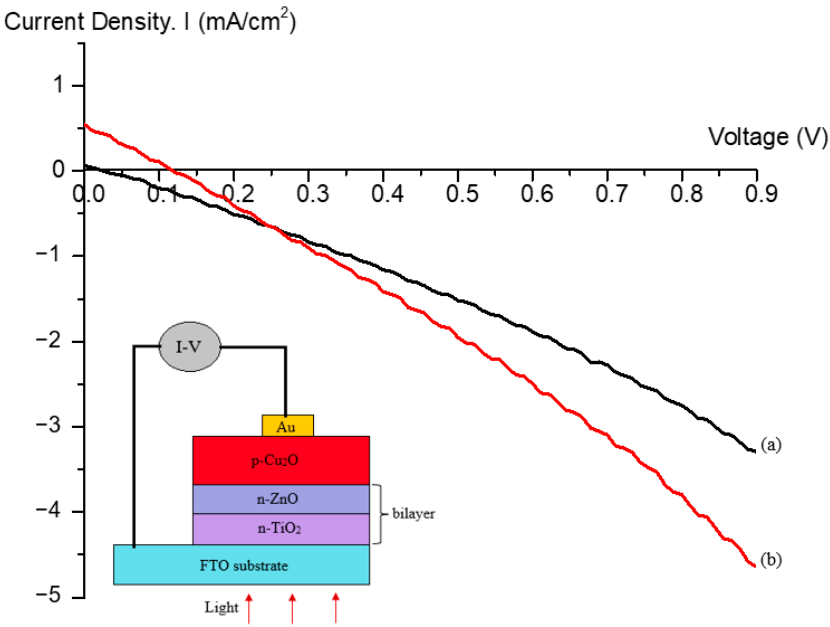
Figure 11. I-V measurement of the n-TiO 2 /ZnO bilayer/p-Cu 2 O heterostructure thin film at ( a ) dark and ( b ) illumination. The inset shows an illustration of the device.